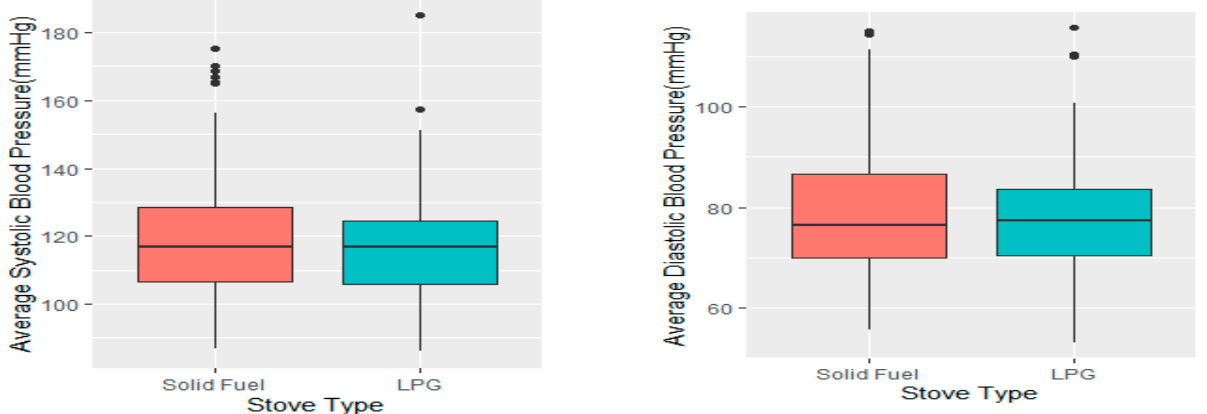
Figure 2. Average systolic and diastolic blood pressure (mmHg) by stove type.